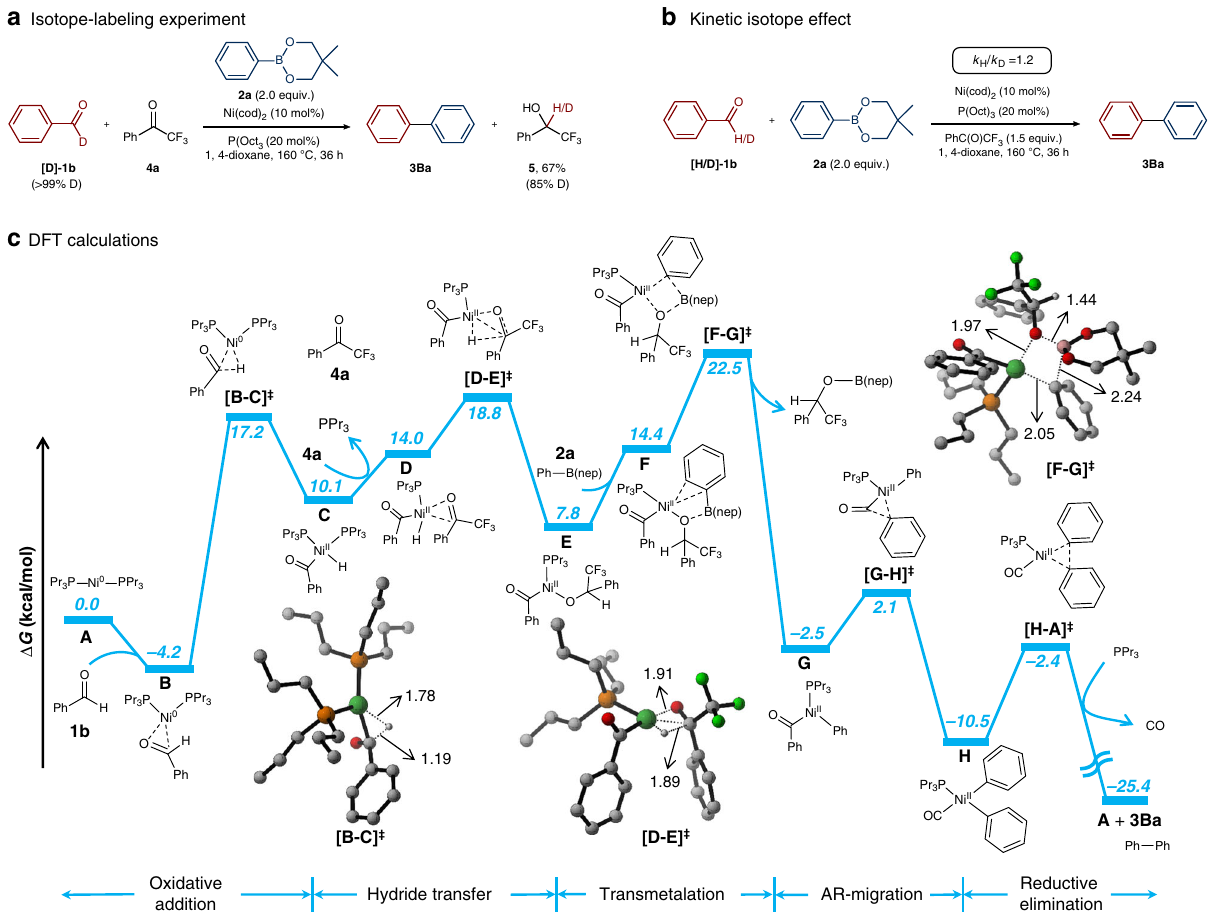
Fig. 4 Mechanistic studies of the Ni-catalyzed deformylative Suzuki – Miyaura cross coupling. a Isotope-labeling experiment. b Kinetic isotope effect experiment. c Full DFT-computed energy pro fi le for the Ni-catalyzed deformylative Suzuki – Miyaura cross coupling with benzaldehyde ( 1b ) and Ph-B(nep) ( 2a ) as reactants and PhC(O)CF 3 ( 4a ) as the hydride acceptor under the Ni(cod) 2 /P n Pr 3 catalytic system. Free energies in solution (in kcal/mol) at the SMD (1,4-Dioxane)-M06/Def2-TZVPP// ω B97xD/Def2-TZVP(Ni)/Def2-SVP(non-metal) level are displayed. Selected DFT optimized geometries are listed. Bond lengths are given in and removed from the glovebox. After stirring at 160 °C for 36h, the mixture was allowed to cool to room temperature, diluted with EtOAc (5 mL) and fi ltered through a celite plug, eluting with additional EtOAc (15 mL). The fi ltrate was concentrated and puri fi ed by column chromatography on silica gel to yield the title product.